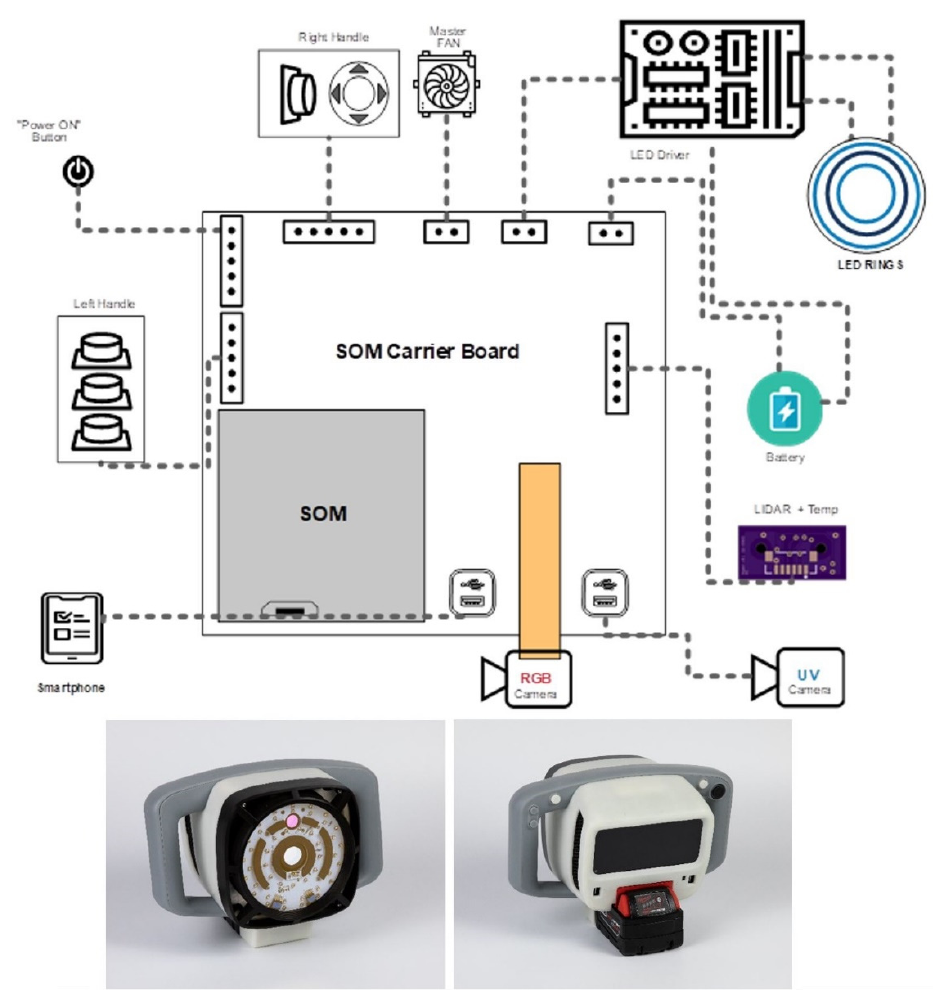
Figure 1. CSI-D system (top: system block diagram, bottom: CSI-D picture).